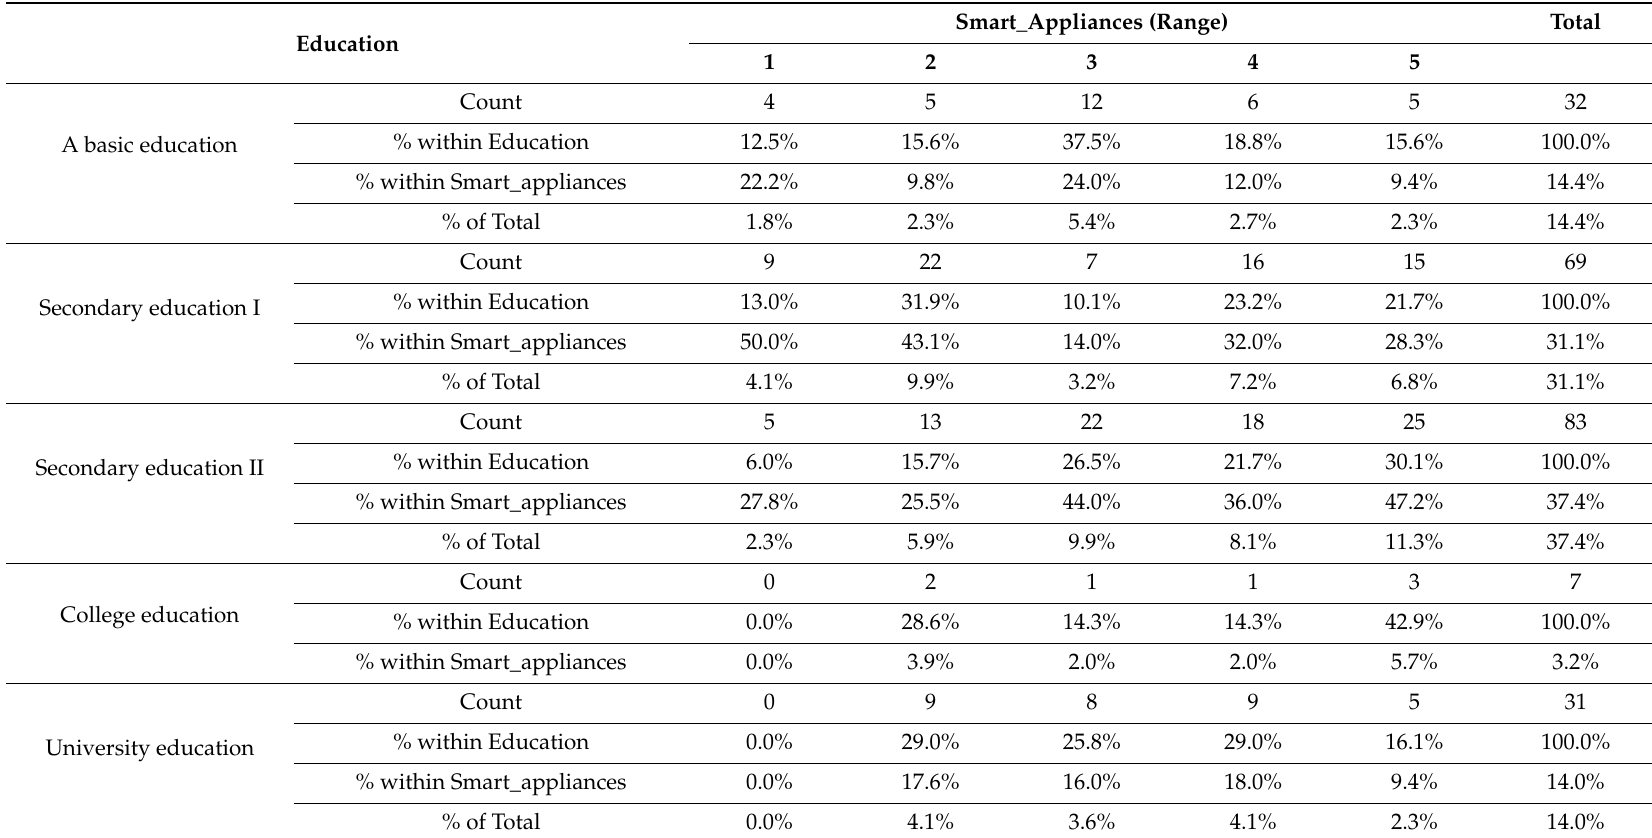
Table 8. Analysis of the dependence of education level on willingness to use ICT (all